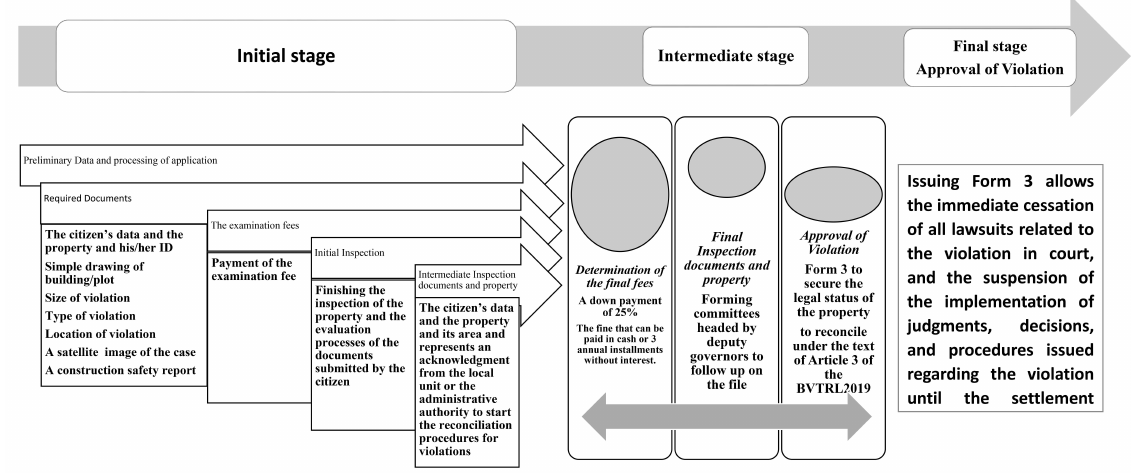
Figure 3. The processes of the submission mechanisms to